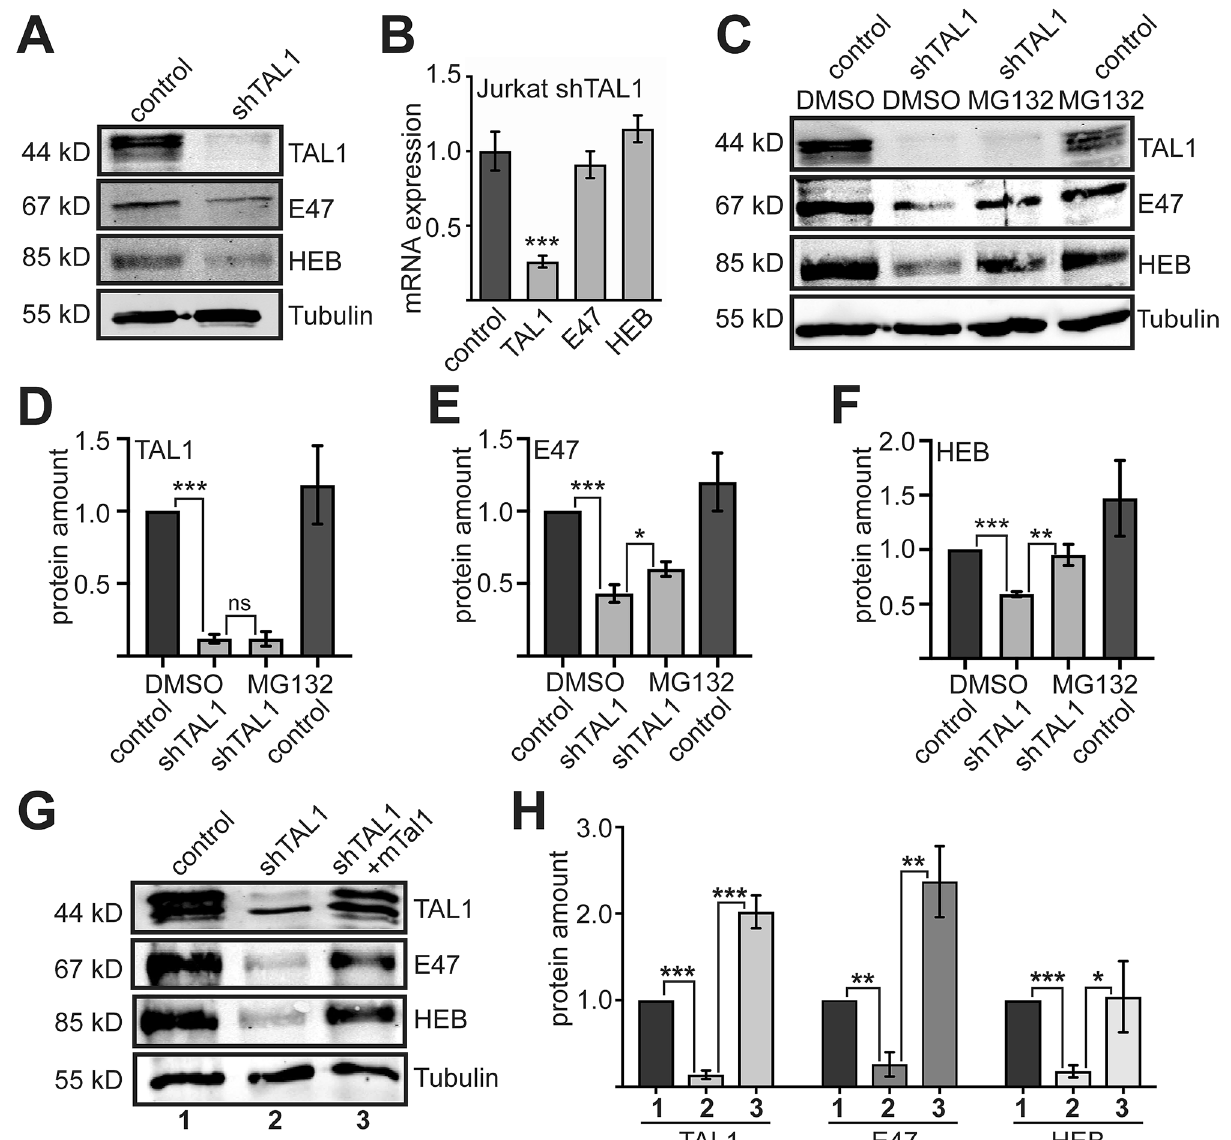
Figure 4. TAL1 knockdown destabilizes E-Proteins. ( A ) Western blot analysis of TAL1, E47 and HEB upon TAL1 knockdown. Jurkat cells were transduced with a small hairpin vector against TAL1 (shTAL1) or control vector with a non-targeting shRNA (control). Western blot with antibodies against TAL1, E47 and HEB revealed reduced protein amount upon knockdown of TAL1. Western blot against Tubulin served as loading control. ( B ) Analysis of the mRNA level upon knockdown of TAL1 by qRT-PCR with primer pairs recognizing the given mRNAs. TAL1 is decreased in TAL1 knockdown cells, while HEB and E47 mRNA level remained unchanged. Values were normalized with values gathered for GAPDH. ( C ) Treatment of TAL1 knockdown Jurkat cells with the protease inhibitor MG132 restored E47 and HEB expression. TAL1 knockdown cells were treated with 3 µM of the proteasome inhibitor MG132 for eight hours. Cells were harvested and applied to western blot analysis against TAL1, E47 and HEB. Western blot against Tubulin served as control. ( D ) Measurement of TAL1 protein amount upon TAL1 knockdown by western blot and quantification using the Odyssey-System. Values were normalized against the loading control Tubulin and are displayed as relative protein amount compared to western blot from cells, which were transduced with a control shRNA. ( E ) Measurement of E47 protein amount upon TAL1 knockdown by western blot and quantification using the Odyssey-System. Values were normalized against the loading control Tubulin and are displayed as relative protein amount compared to western blot from cells, which were transduced with a control shRNA. ( F ) Measurement of HEB protein amount upon TAL1 knockdown by western blot and quantification using the Odyssey-System. Values were normalized against the loading control Tubulin and are displayed as relative protein amount compared to western blot from cells, which were transduced with a control shRNA. ( G ) Rescue of TAL1 expression in TAL1 knockdown Jurkat cells restores E47 and HEB protein expression. TAL1 knockdown cells were additionally transduced with murine Tal1 (mTal1) to restore TAL1 protein amount. Western blot analysis revealed a rescue of E47 and HEB protein amount. Tubulin served as loading control. ( H ) Measurement of TAL1, E47 and HEB protein amount upon TAL1 knockdown and restoration of TAL1 expression by western blot and quantification using the Odyssey-System. Quantification of TAL1, E47 and HEB protein level upon re-expression of TAL1 expression levels in shTAL1 Jurkat cells with mTal1. Values were normalized against the loading control Tubulin and are displayed as relative protein amount compared to western blot from cells, which were transduced with a control shRNA. Error bars were determined from at least three independent experiments. P-values were calculated using Student’s t-test from at least three independent western blots. One representative blot is shown. *P < 0.05; **P < 0.01; ***P <